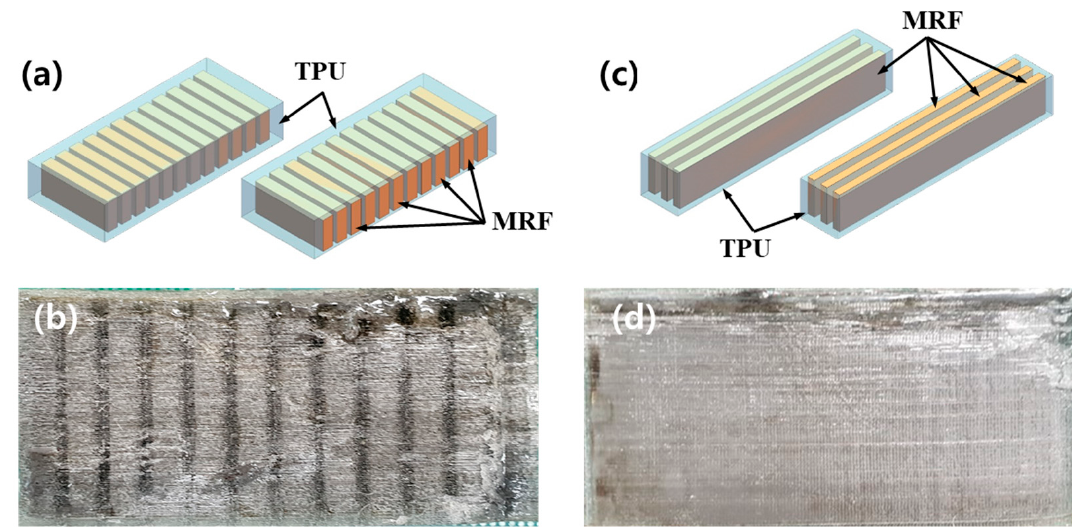
Figure 5. Specimens (TPU and MRF): ( a , c ) schematics and ( b , d ) surface photographs of specimens 1 and 2, respectively.